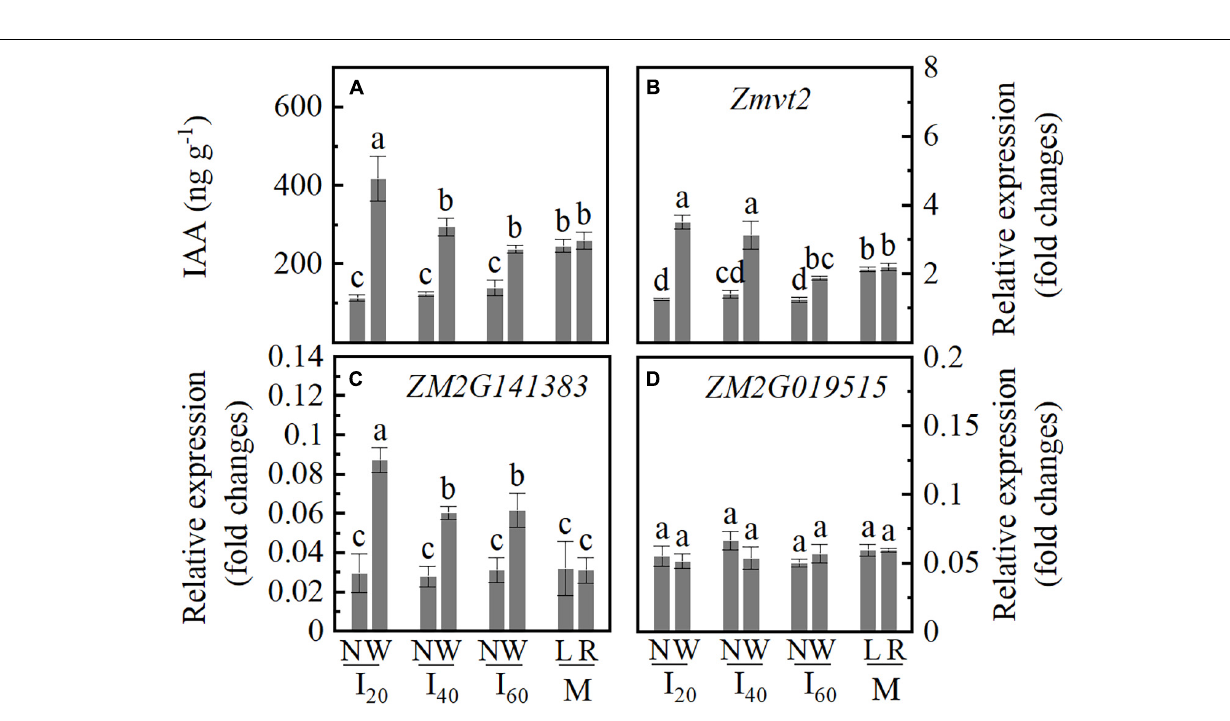
Frontiers in Plant Science |